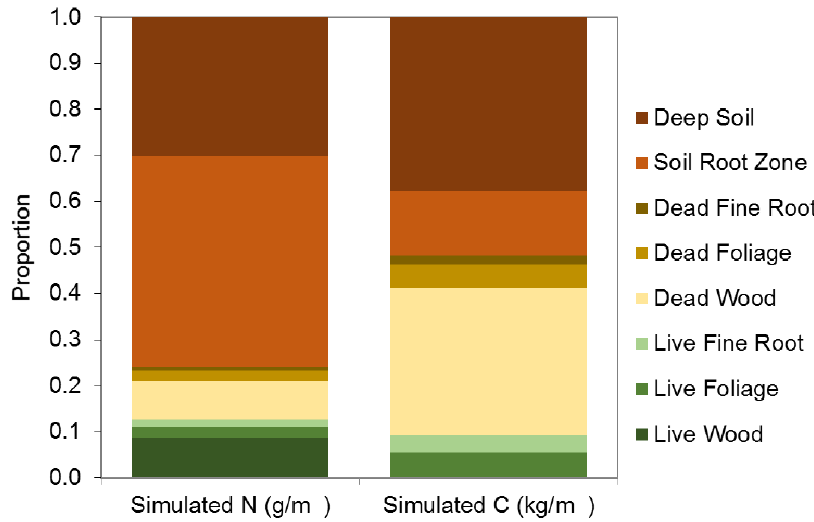
Figure 4. Model results for average annual storage of nitrogen and carbon. Results